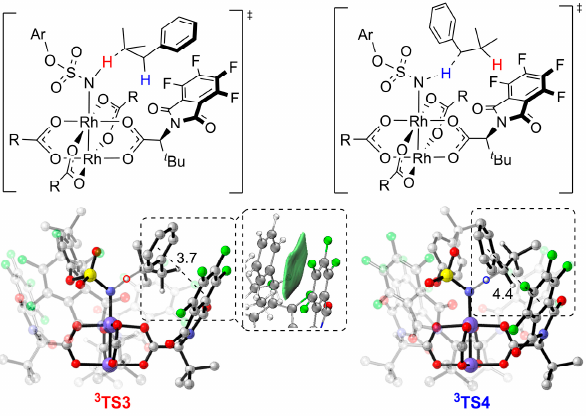
Figure 11. IGM analysis of 3 TS3 and 3 TS4 . Ar = p − tert − butylphenyl. The distances are in Å. The H atoms of t Bu groups and aryl groups are omitted for clarity.